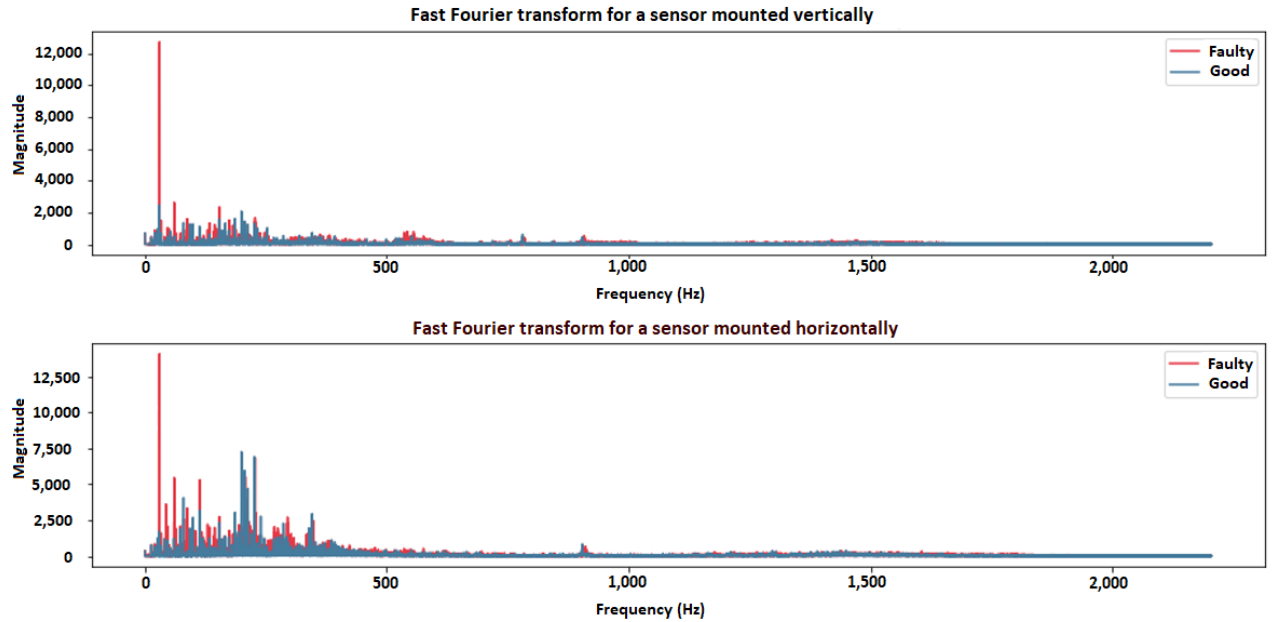
Figure 3. Fault pulley analysis.